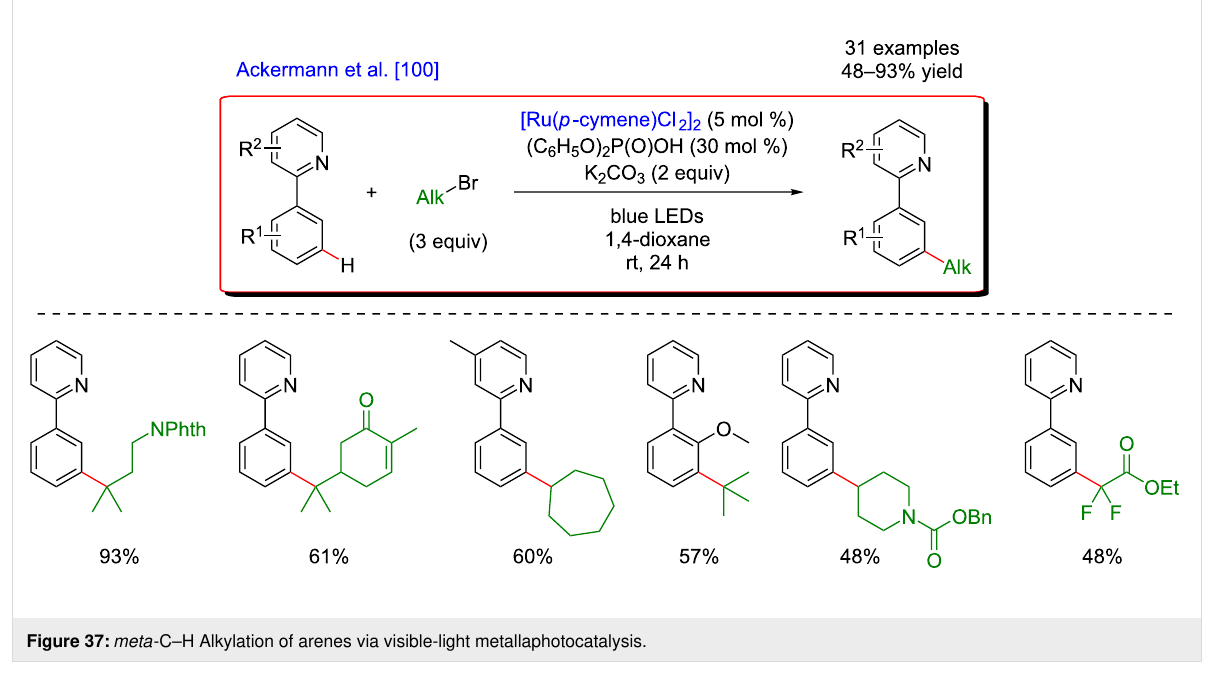
of the crude reaction mixture with Oxone, a large panel of the corresponding hydroxylated pyridine